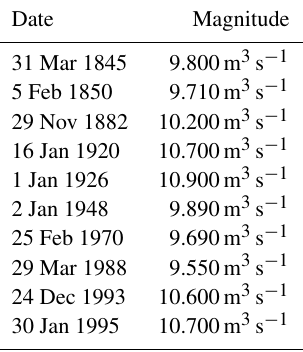
Table 1. Date of occurrence and magnitude of the 10 flood events recorded at the Köln gauging station used in this